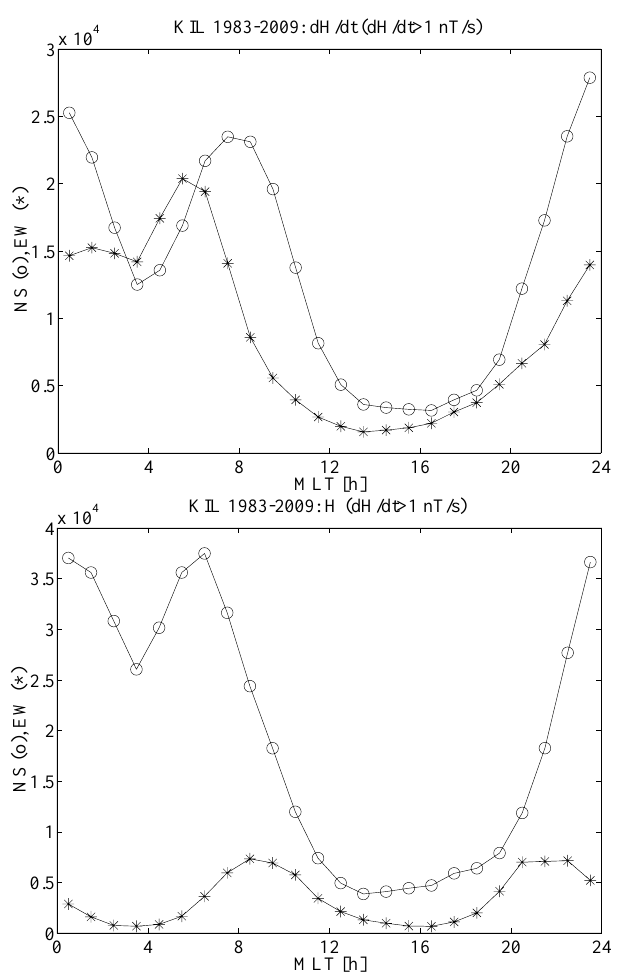
Fig. 2. Upper panel: number of large d H /dt in NS (circles) and EW (asterisks) sectors at KIL (see text for the definitions of the sectors). Lower panel: the same for H